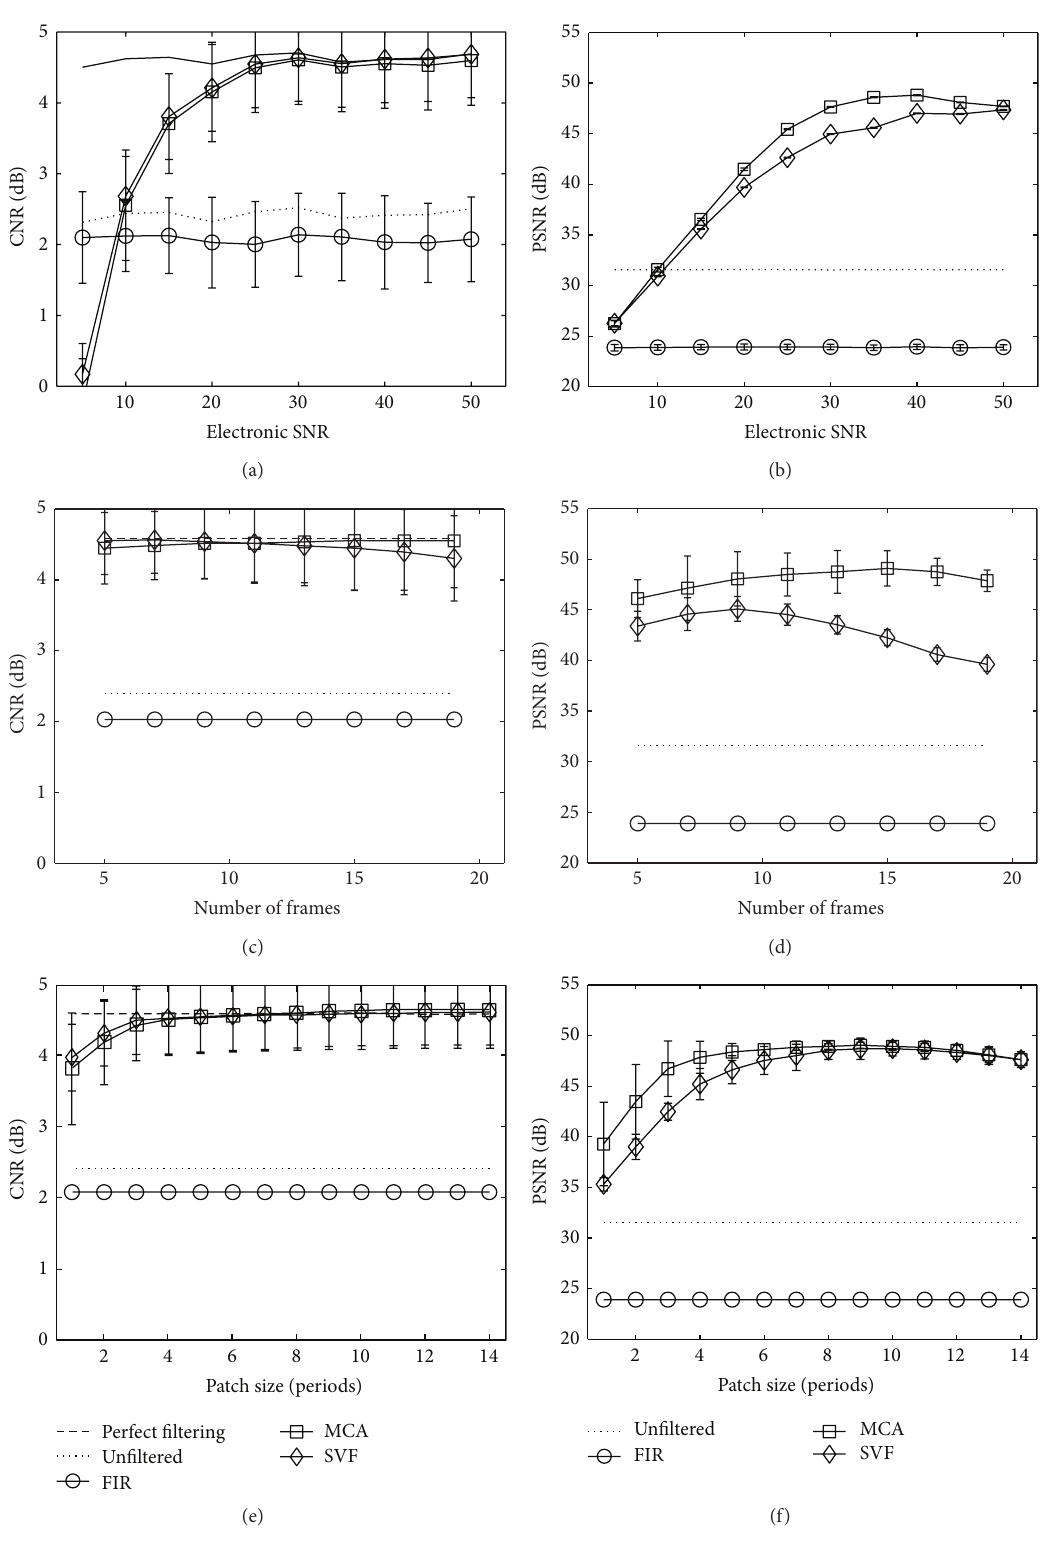
Figure 9: Mean CNR measurements for MCA, SVF, and FIR methods for varied (a) electronic SNR, (b) patch size in temporal dimension, and (c) patch size in axial dimension. Markers represent mean CNR and error bars the standard deviation over 100 simulations. The dashed line, labeled “perfect filtering,” represents the mean CNR when the clutter artifacts are not present in the simulated echo data. Likewise, “unfiltered” represents the CNR or PSNR of the measured data with clutter artifacts and when no filtering technique is